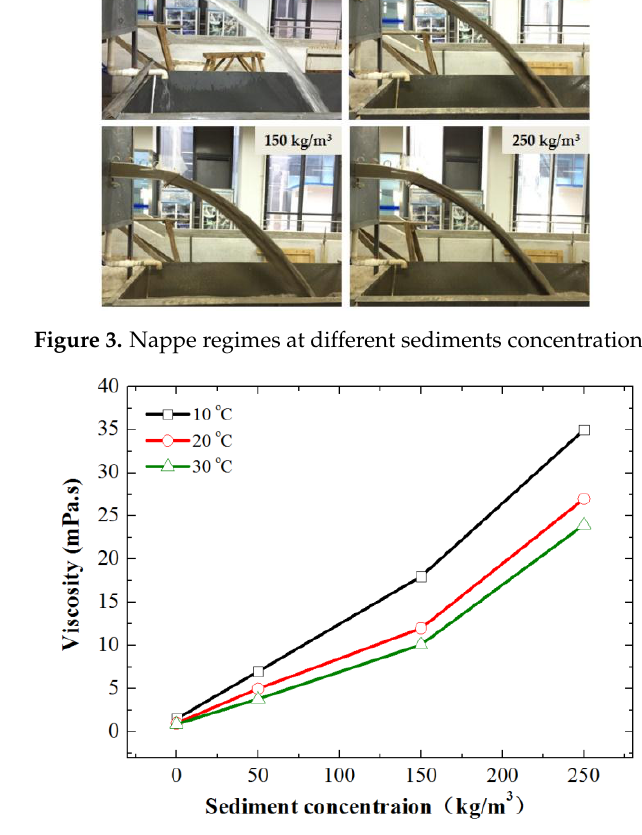
Figure 4. Relationship between various sediment concentrations and fluid viscosity.